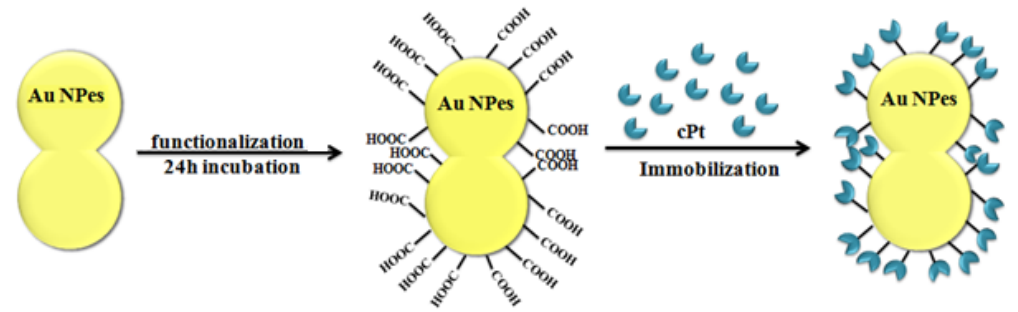
Figure 4. Scheme of the Au NPes functionalization process.